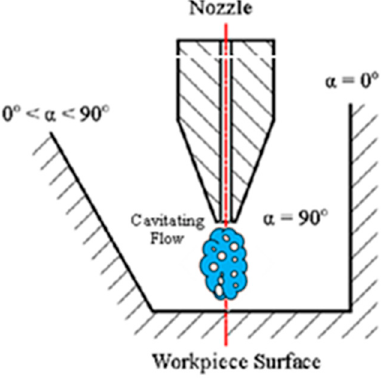
Figure 3. Cavitation peening